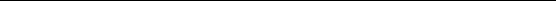
Fig. 2 Brd4 controls cell identity gene induction during adipogenesis. a – e Brd4 is required for adipogenesis of brown preadipocytes. SV40T- immortalized Brd4 f/f brown preadipocytes were infected with adenoviral GFP or Cre, followed by adipogenesis assay. a qRT-PCR con fi rmation of Brd4 deletion in preadipocytes. b Deletion of Brd4 was con fi rmed by western blot analysis. RbBP5 was used as a loading control. c Deletion of Brd4 has little effect on the growth of immortalized preadipocytes. d Oil red O staining at D6 of adipogenesis. Upper panels, stained dishes; lower panels, representative fi elds under microscope. Scale bars = 15 μ m. e qRT- PCR of Brd4 , Pparg , Cebpa , and Fabp4 expression at indicated time points during adipogenesis. D0/2/4/6, day 0/2/4/6. The data are presented as means ± SD. Three technical replicates from a single experiment were used. f , g Brd4 is required for induction of cell identity genes during adipogenesis. Cells were collected before (D0) and during (D2) adipogenesis for RNA-Seq. (f) Schematic of identi fi cation of Brd4- dependent and -independent up-regulated genes during adipogenesis. The cutoff for up- or down-regulation is 2.5-fold. The cutoff for Brd4 dependency is 2.5-fold. g Gene ontology (GO) analysis of gene